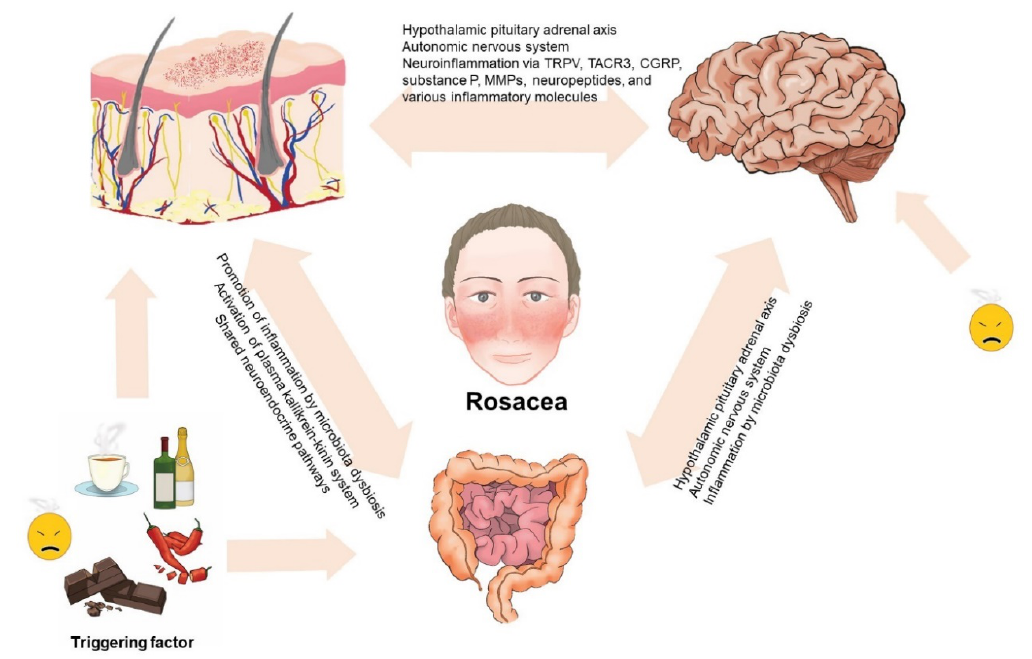
Figure 2. Proposed role of the gut–brain–skin axis in rosacea. The complex interplay among the skin, gut, and brain sustains an intricate balance. Disturbances in the balance might influence the function of the skin, gut, and brain and the occurrence of rosacea and its mental, psychiatric, and gastrointestinal comorbidities.